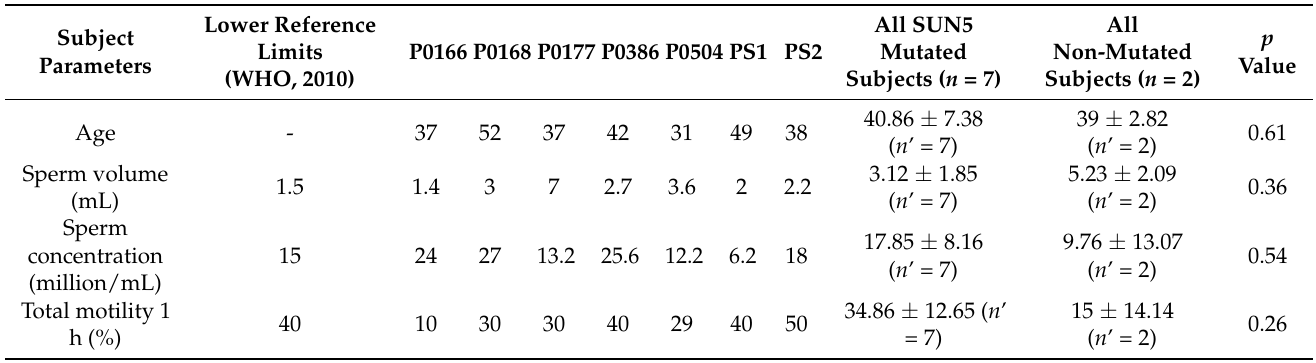
Table 1. Detailed semen parameters of subjects carrying the SUN5 homozygous variant (c.211+1_211+2dupGT) and statistical comparison of the mean of the semen parameters between these subjects and those with unknown